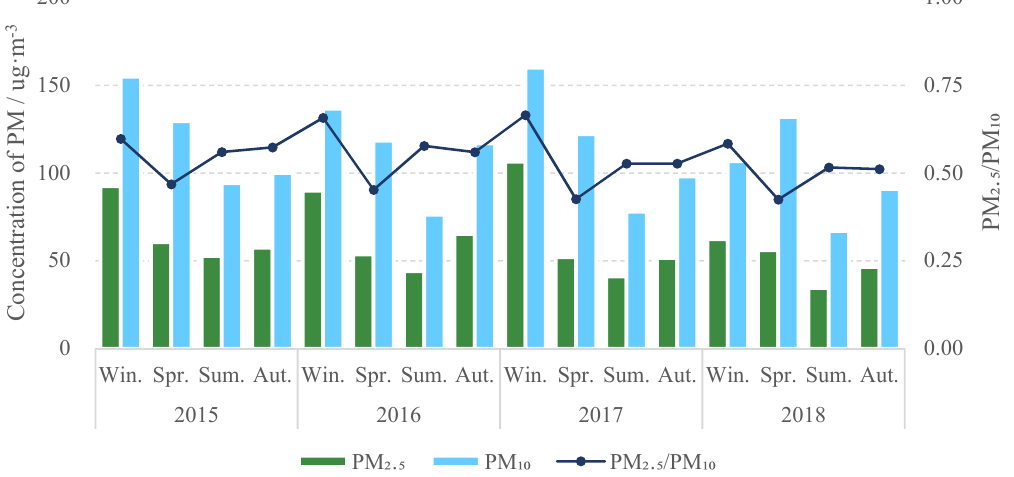
Figure 5. Temporal variation in the seasonal mean value of atmospheric particulate matter concen ‐ tration.